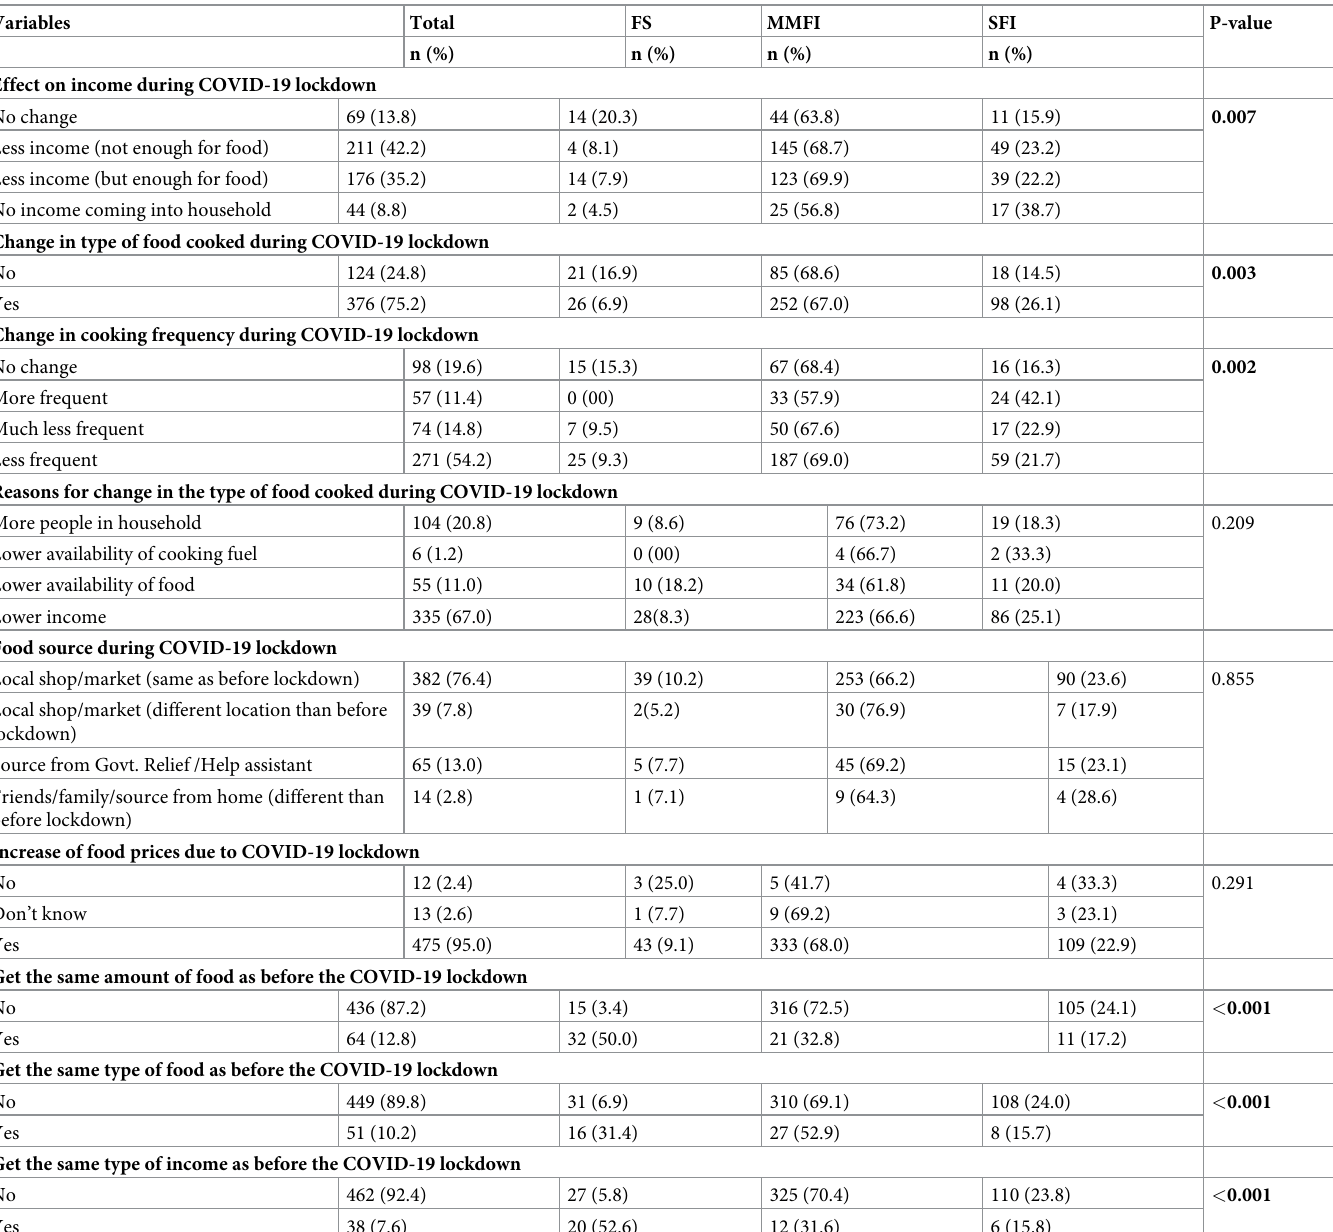
Table 2. Effect on income conditions and food accessibility during COVID-19 among respondents with household food insecurity (n = 500).